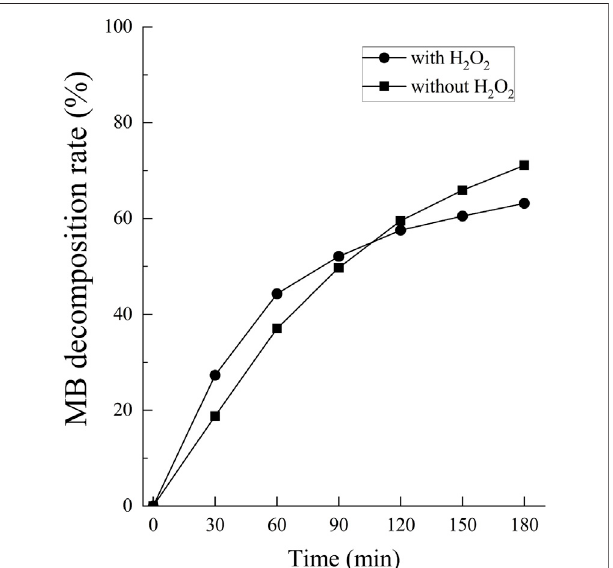
FIGURE 9 | The comparison of the degradation rate of MB between anodic oxides in the sodium tartrate electrolyte with and without H 2 O 2 . The sample size is n = 1 in each group. MB: Methylene blue.